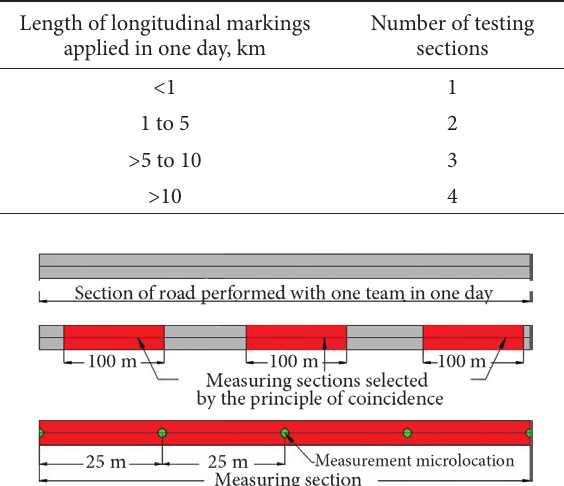
Fig. 1. Measurement principle according to ZTV M 02 (static